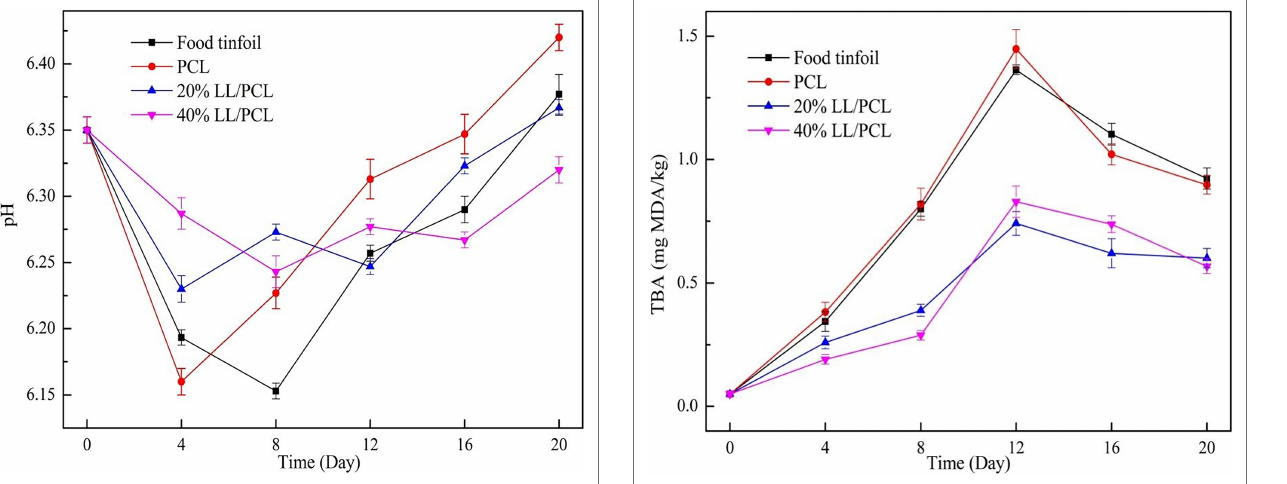
FIGURE 9 | Changes in TBARS value of salmon. FIGURE 7 | Changes in pH of salmon.